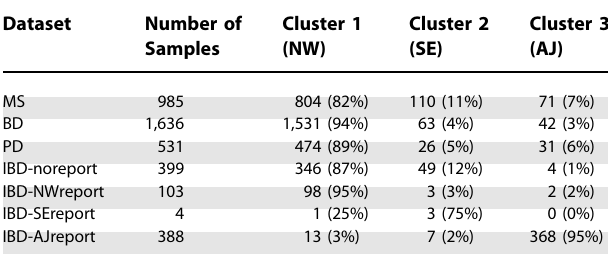
Table 1. Inferred Ancestry of Individuals in the MS, BD, PD, and IBD Datasets Dataset